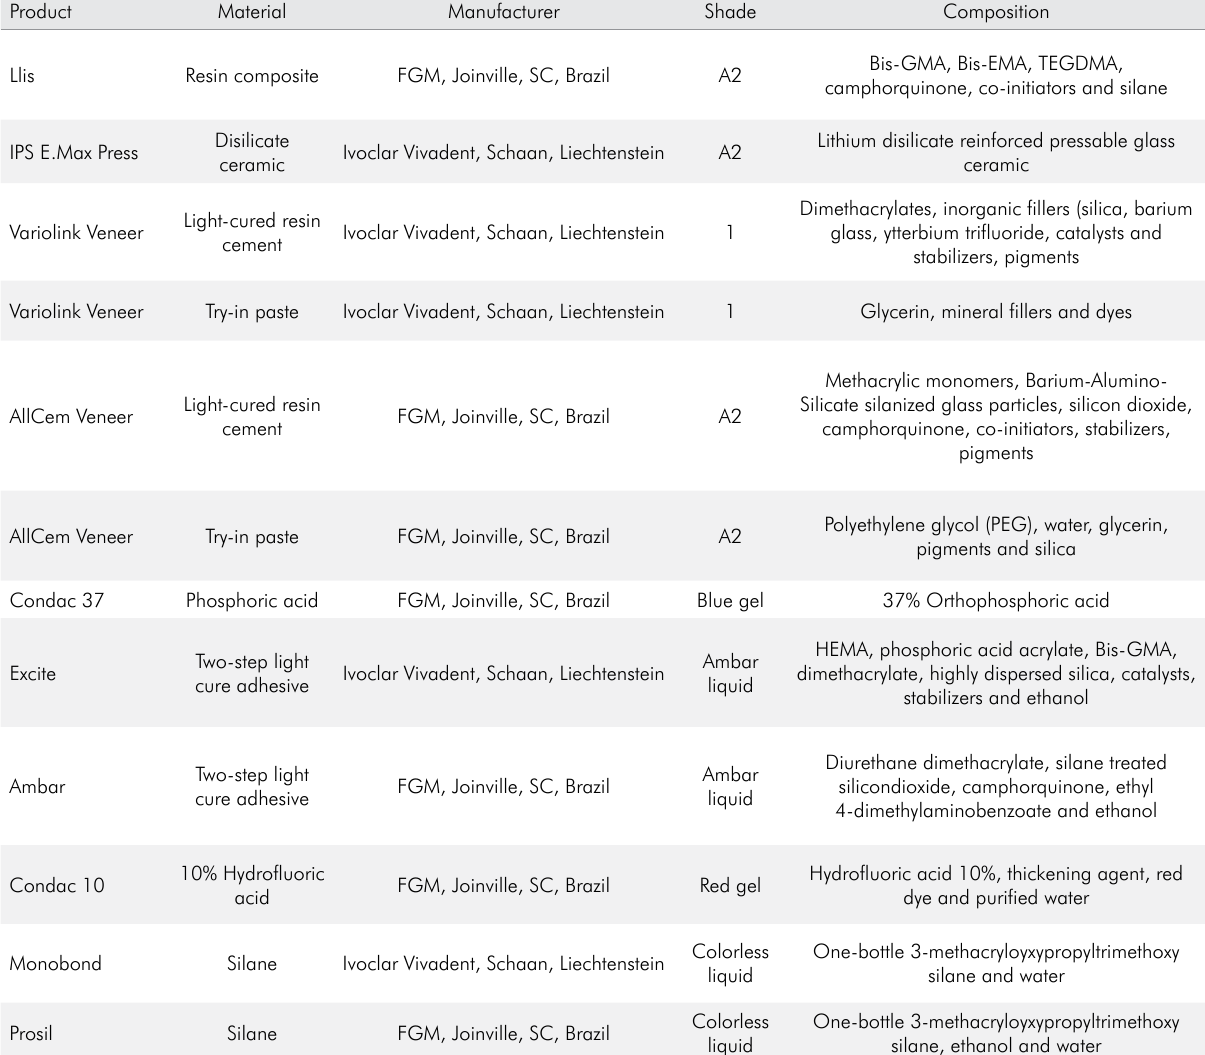
Table 3. Materials used and